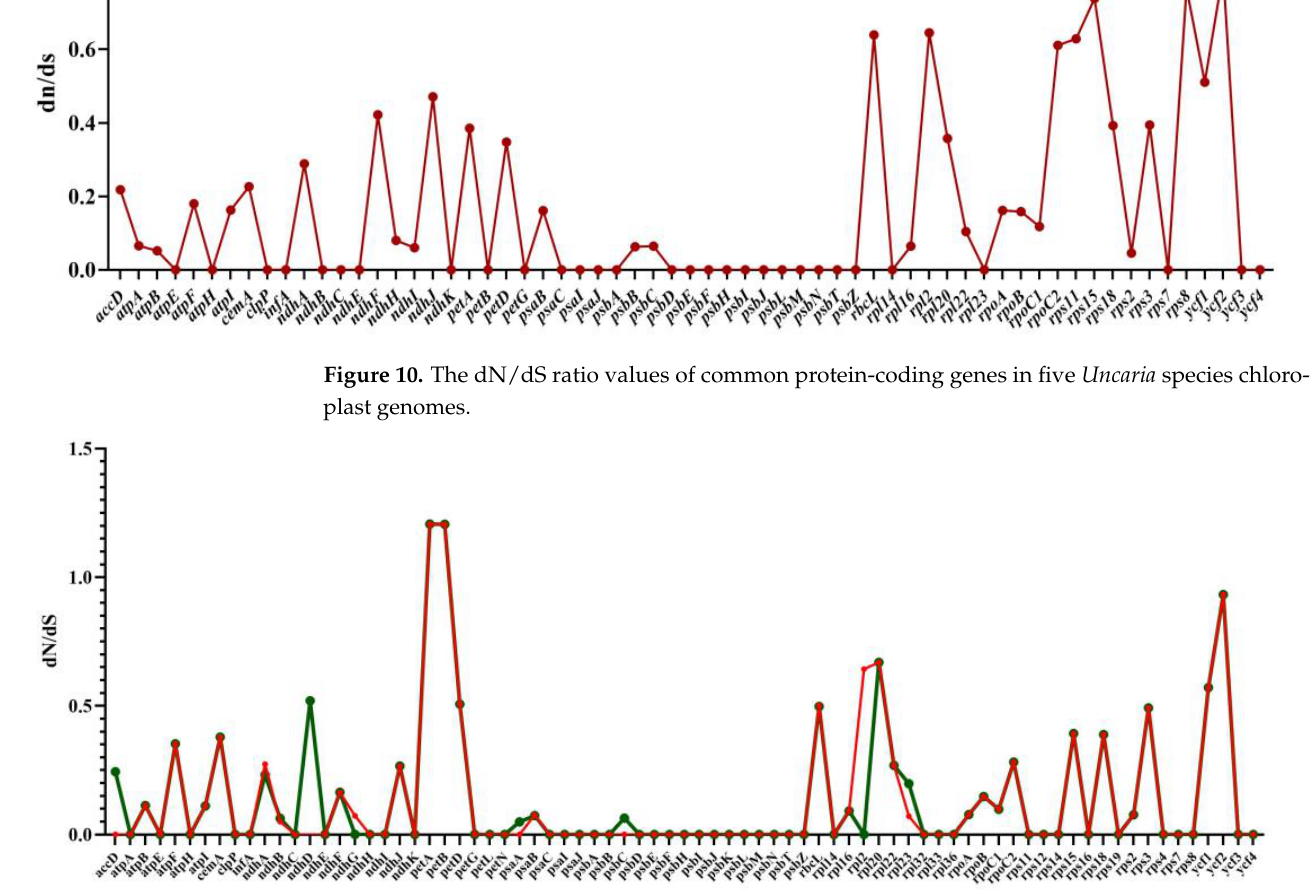
Figure 11. The dN/dS ratio values of common protein-coding genes in U. macrophylla , U. hirsuta, and U. rhynchophylla .